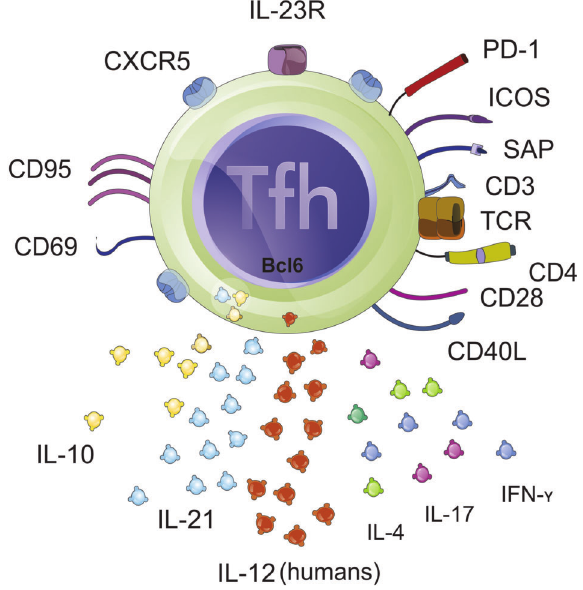
Figure 1. Follicular helper T cells (Tfh) lymphocytes are critically involved in the formation of germinal centers and in the development of T cell-dependent B cell response in secondary lymphoid tissues. The fi gure represents Tfh cells with their most important membrane molecules, transcription factor and soluble effector